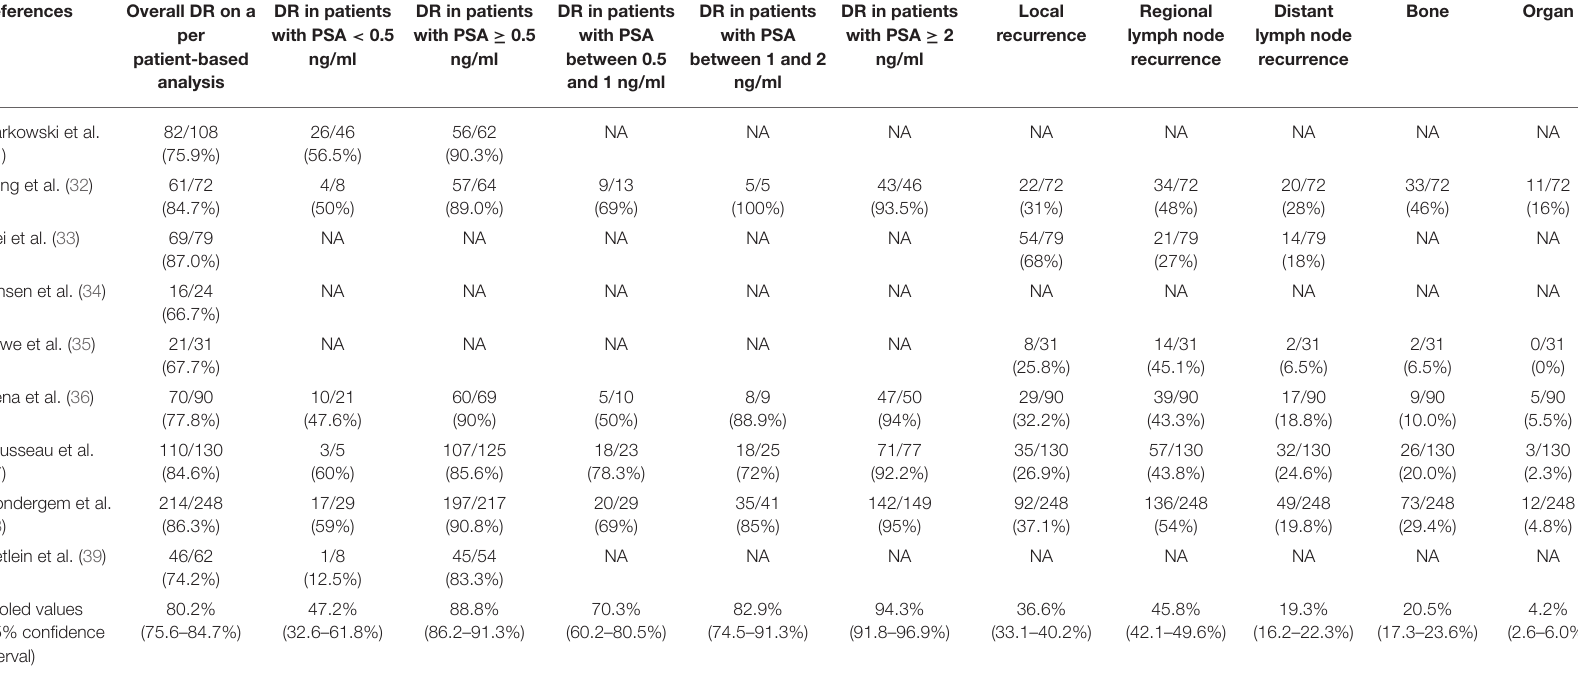
TABLE 3 | Main findings of the included studies about 18F-DCFPyL PET/CT in BRPCa